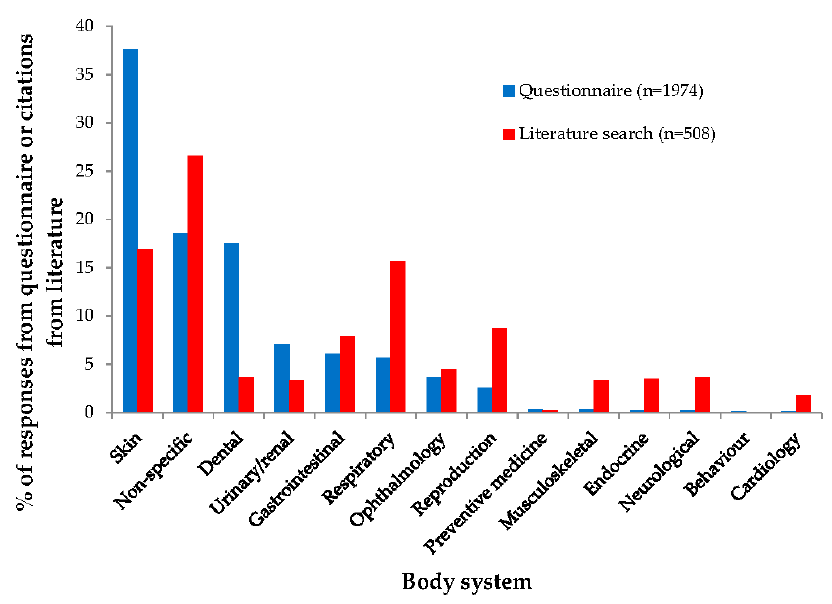
Figure 4. Body system category selected for 1974 guinea pig conditions nominated during a survey of UK veterinarians, and 508 guinea pig citations identified during a literature search.